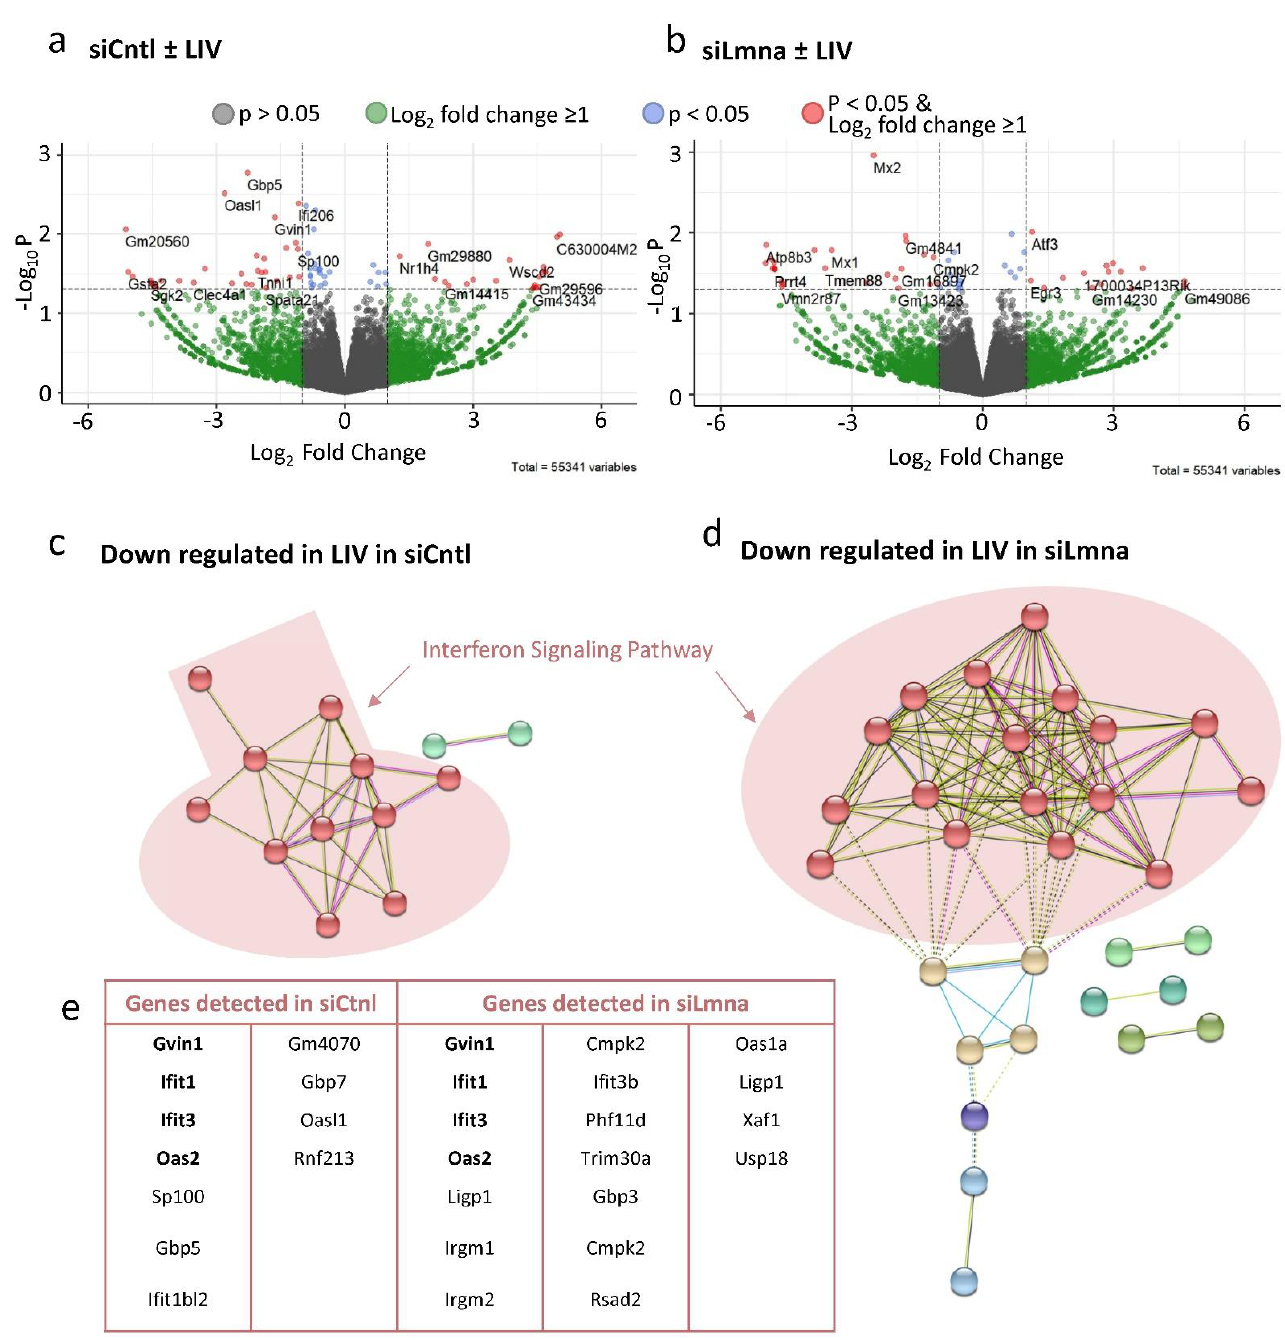
Figure 7. Low Intensity Vibration Decreases Interferon Signaling Pathway Gene Expression: ( a ) Volcano plot comparing the siCntl adipogenesis with or without LIV treatment (siCntl ± LIV). ( b ) Volcano plot comparing the siLmna adipogenesis with or without LIV treatment (siLmna ± LIV). Genes with Wald values greater than p value of 0.05 are colored in grey. Genes with differential gene expression equal to or larger than 2-fold ( Log 2 = 1) but have Wald values greater than p value of 0.05 are colored in green. Genes colored with blue have Wald values smaller than p value of 0.05, but differential gene expression less than 2-fold ( Log 2 = 1). Genes with Wald values smaller than p value of 0.05 and differential gene expression equal to or larger than 2-fold ( Log 2 = 1) are colored in red. Both siCtnl ( c ) and siLmna ( d ) showed downregulation of genes closely associated with interferon signaling pathway. ( e ) Cells treated with siCntl had 11 genes associated with interferon signaling pathway while siLmna treated cells had 16 genes associated with the interferon signaling pathway that had decreased expression. Bolded gene names ( Gvin , Ifit1 , Ifit3 , and Oas2 ) names were found in both siCntl and siLmna treated